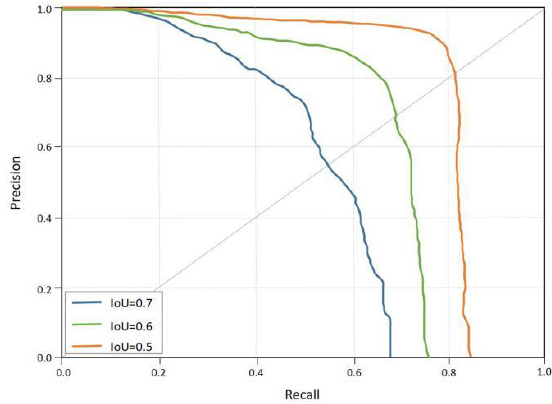
Figure 7. PR curves under different IoU thresholds.